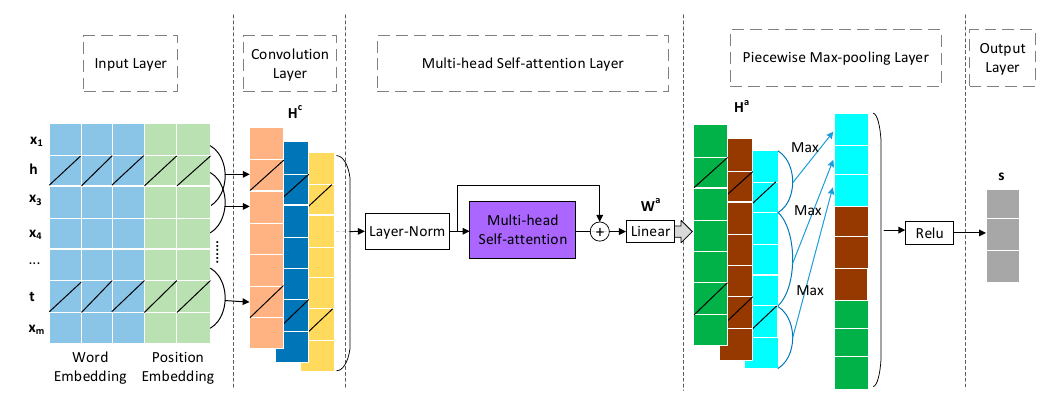
Figure 3. Infrastructure of our sentence encoder. Relu: Rectified Linear Unit.